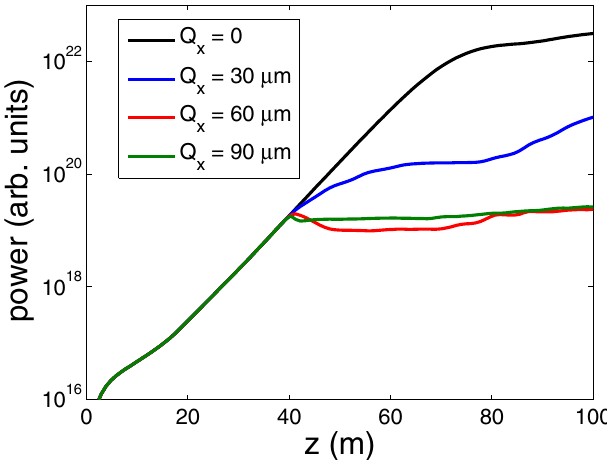
FIG. 14. (Color) GENESIS simulation of the LCLS far-field power for various quadrupole offsets Q